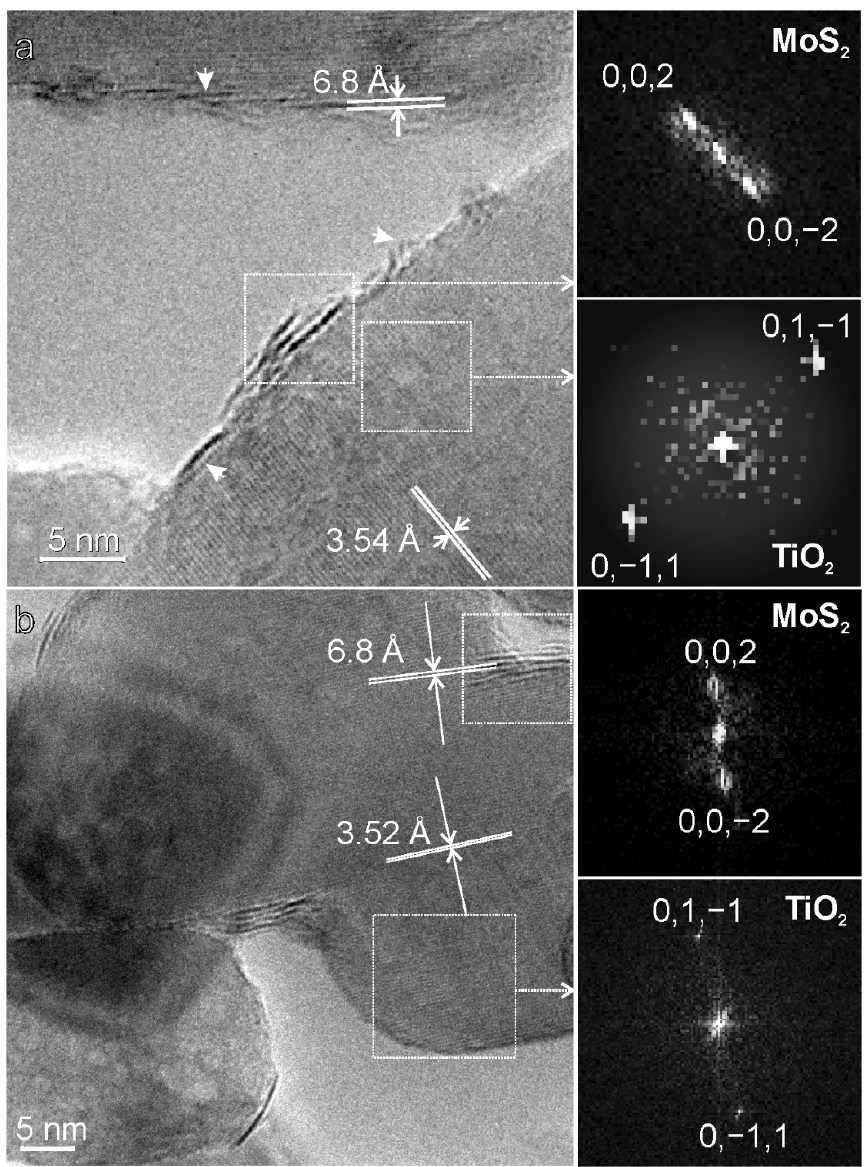
Figure 3. HRTEM images of: ( a ) MoS 2 /TiO 2 n-sh and ( b ) MoS 2 /TiO 2 bipy nanoparticles. In the insets, fast-Fourier-transform (FFT) images of selected regions in a and b are shown.